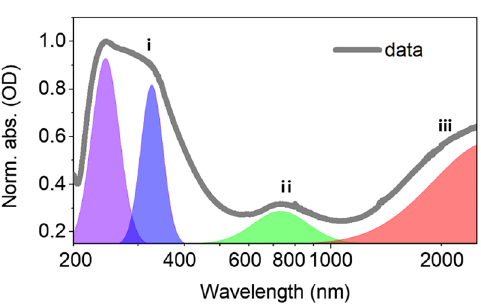
Figure 1: Morphology characterization and structure model of MXene nanosheets. (a and b) SEM images at scale bar of 1 μ m and 400 nm. (c) AFM image showing the surface morphology of the monolayer MXene nanosheets. (d and e) Top and side views of the model of MXene with OH functional groups, i.e. , Ti 3 C 2 (OH) 2 . Grey, dark grey, red, and white balls show the positions of transitional metals, carbon, oxygen, and hydrogen atoms, respectively. (f)TopviewHRTEMimageshowingthe(100) plane. Inset is the selected area electron diffraction (SAED) pattern. (g) Side-view HRTEM image.